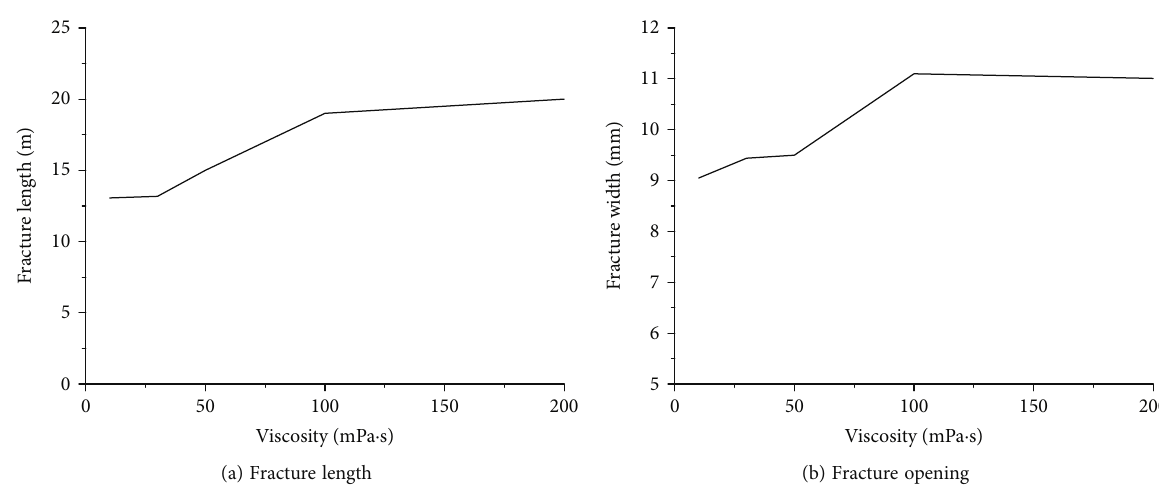
Figure 31: Fracture length and width at the NF approaching angle of 45 ° and under fl uid viscosity of 10-200 mPa · s.